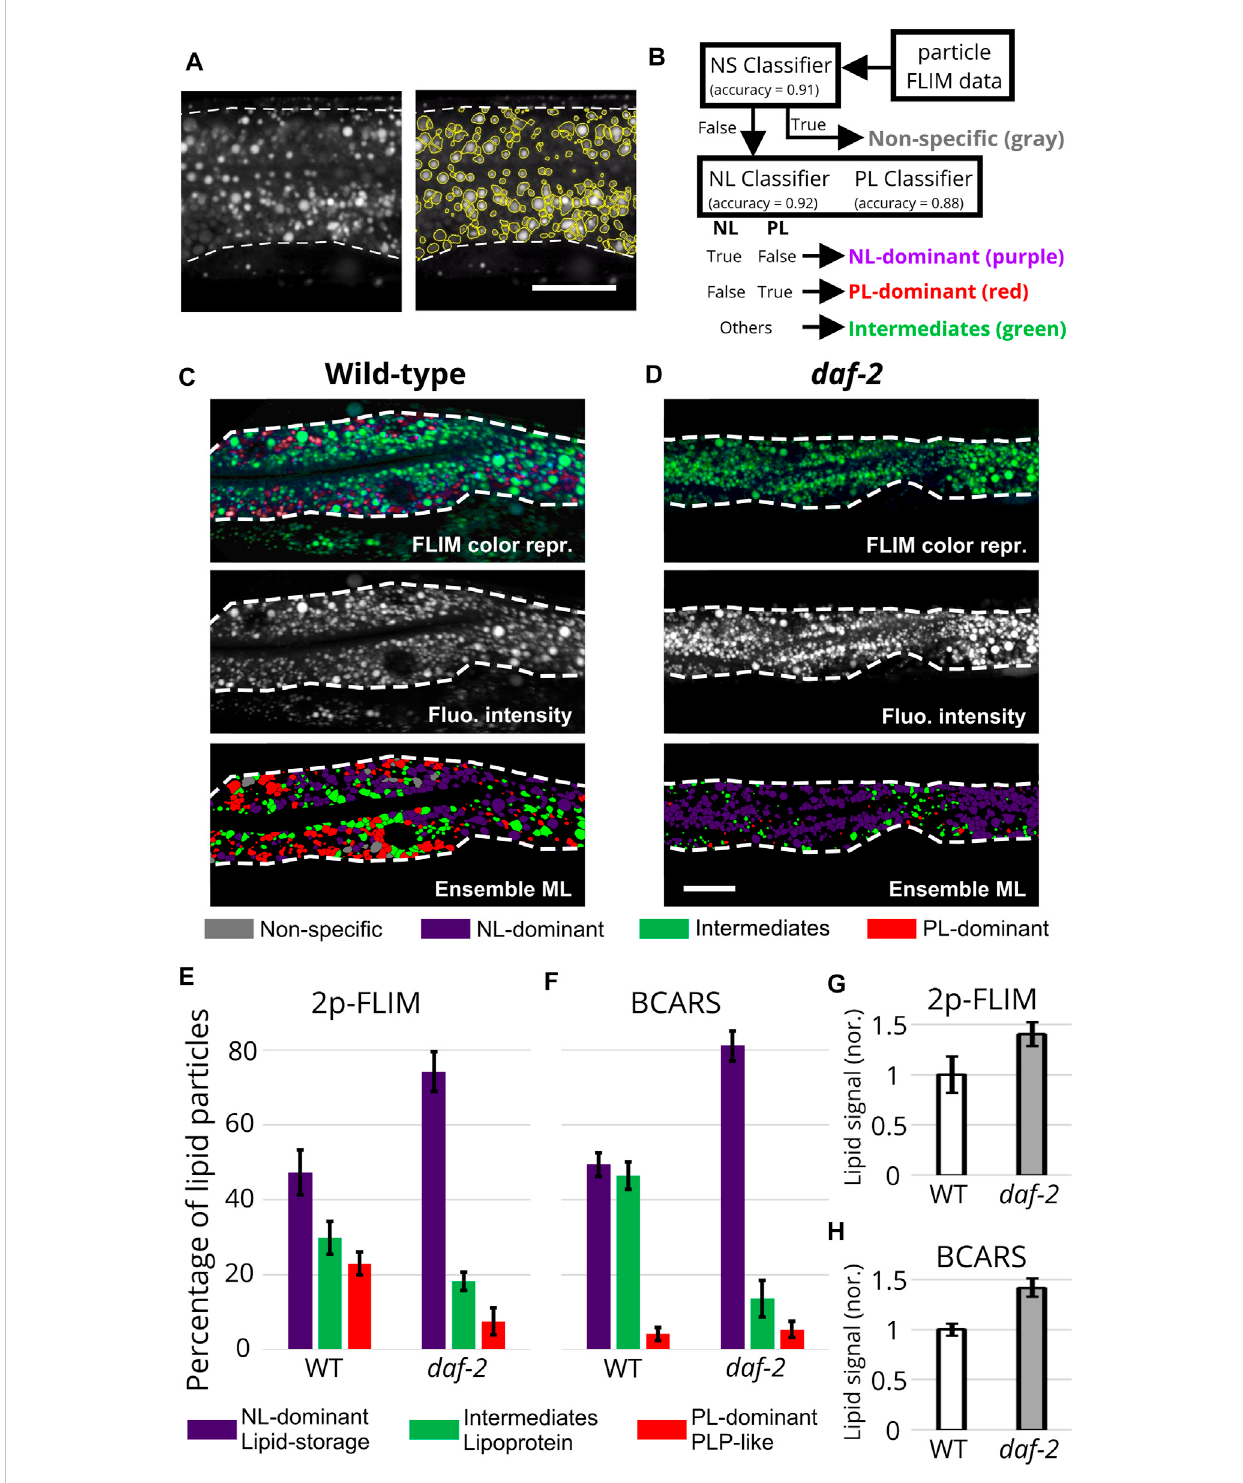
FIGURE 4 Classi fi cation of lipid particles imagedby NileRed 2p-FLIM and label-free BCARS. (A) The results of marker-controlled watershed segmentation. (B) The classi fi cation pipeline of ensemble classi fi cation. NL, non-polar lipid; PL, polar lipid. (C) , (D) From upper to bottom, FLIM color representation, fl uorescence intensity, and the results of ensemble classi fi cation for wild-type and daf-2 1-day adult worms. Scale bar, 20 μ m. (E) , (F) The comparison between 2p-FLIM and BCARS classi fi cation. (G) , (H) The normalized intestinal lipid signal obtained by NR-2p-FLIM after eliminating non-speci fi c binding signal and BCARS 2845 cm − 1 signals. Both results are the integrated signals divided by the area of the intestine. For Nile Red 2p-FLIM, data were obtained from n = 8 and 9 animals for wild-type and daf-2 , respectively. About 4,200 (wild-type) and 5,900 ( daf-2 ) lipid particles were analyzed. For BCARS, data were obtained from n = 5 animals for both wild-type and daf-2 , and about 1,170 (wild-type) and 3,200 ( daf-2 ) lipid particles were analyzed. Error bars represent the standard error of the